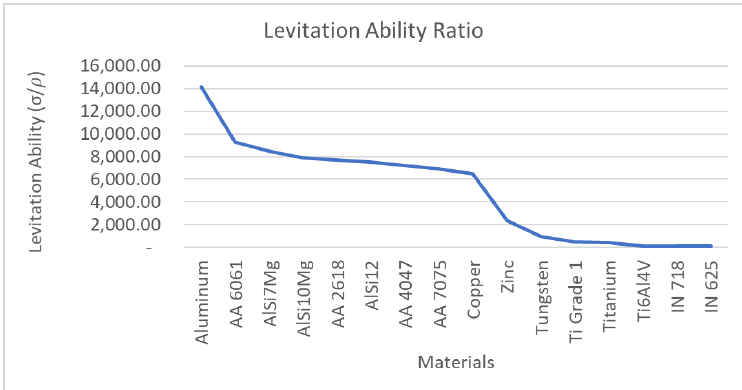
Figure 2. Levitation ability: the ratio of σ